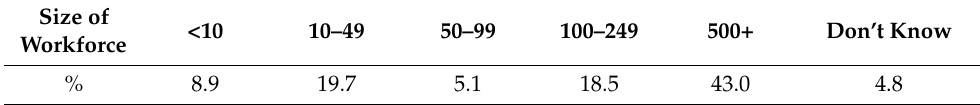
Table 4. Number of employees at respondent’s organisation (n = 299).